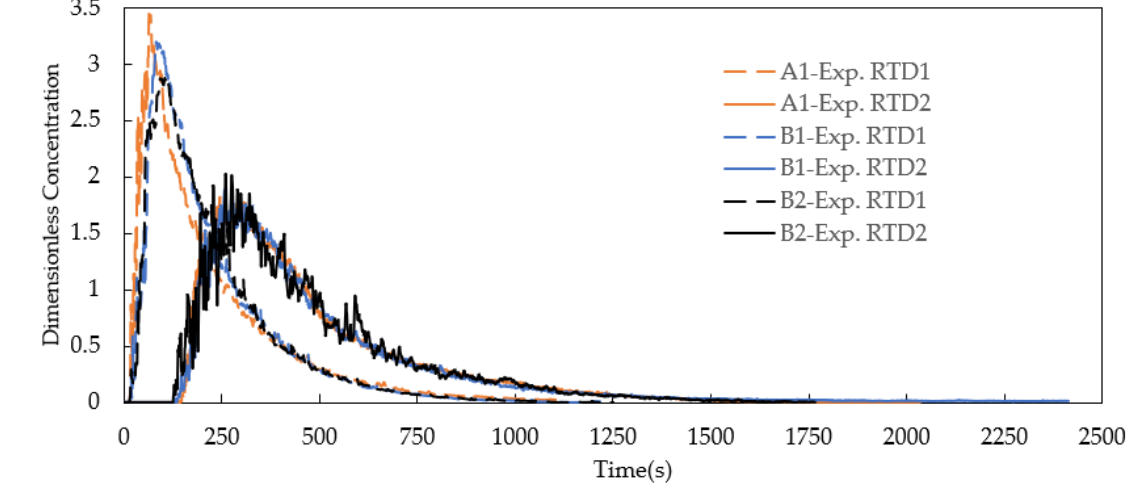
Figure 6. Measured RTD curves of Cases A1, B1 and B2.